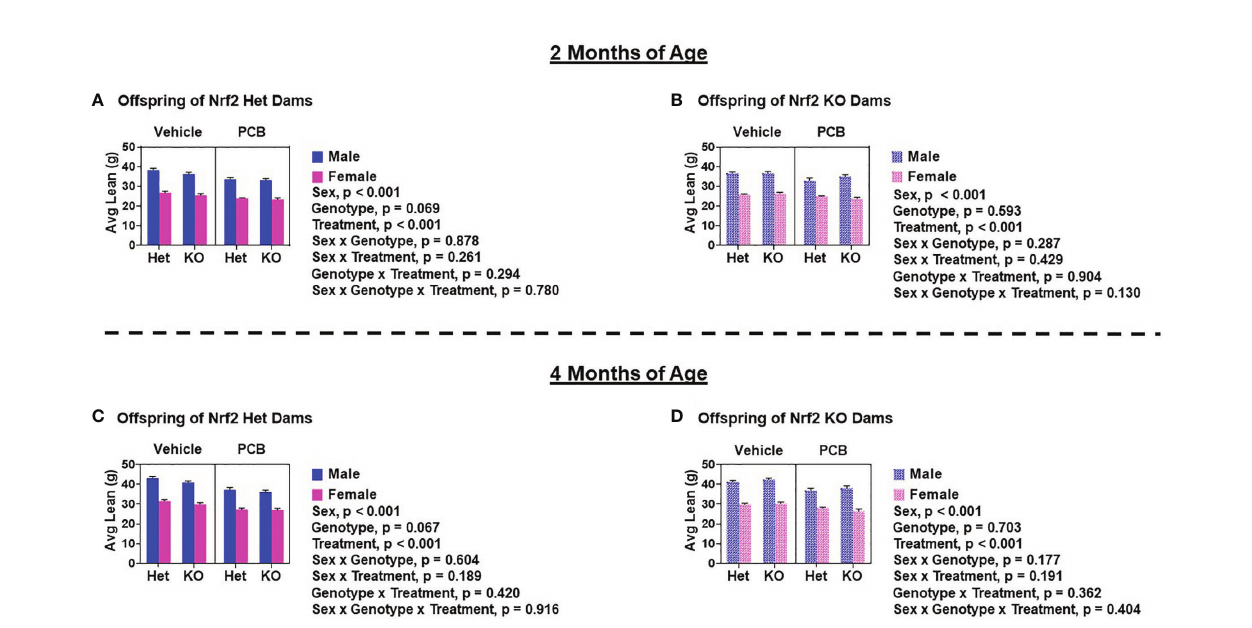
FIGURE 3 | PCB126 exposure during gestation adversely in fl uences lean mass pro fi les in adult offspring. Displayed average lean mass measurements of offspring of Nrf2 heterozygous (A, C) and knockout (B, D) dams at two and four months of age were taken using EchoMRI. Values are representative of the mean of litter means (n = 8 – 13 per group) ± SEM. Three-factor ANOVA was used to analyze data. Signi fi cance was set at a = 0.05.